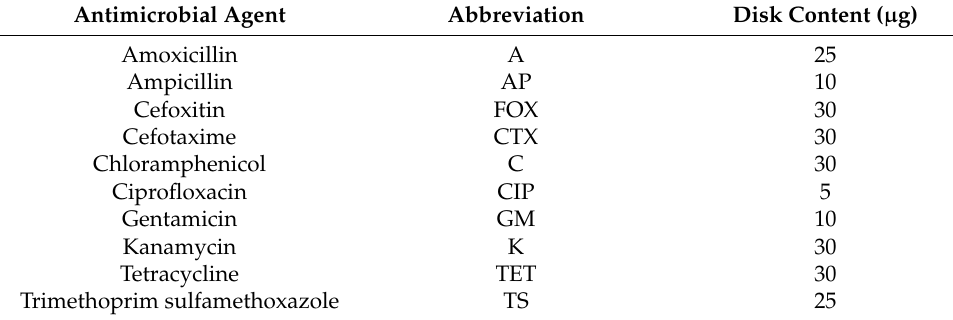
Table 1. Disk content of